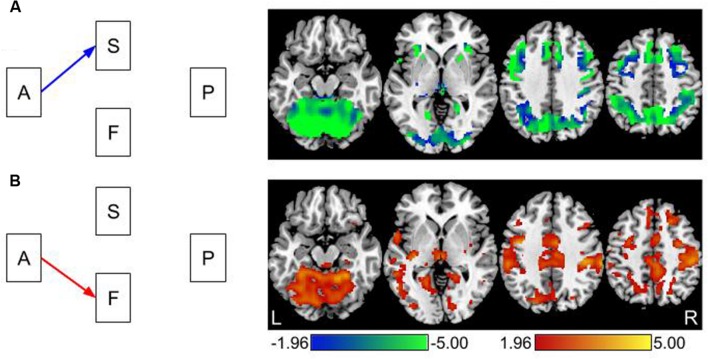
Direct effects of age on gray matter volume and brain activity.
(A) The effect of age on gray matter volume using voxel based morphometry (VBM). All effects are in the negative direction; older adults have lower gray matter volume than young adults. This is represented with a blue arrow in the path model on the left. (B) The effect of age on brain activation. All effects are in the positive direction; older adults have greater levels of task-related brain activation than young adults. This is represented with a red arrow in the path model on the left. Images are thresholded using a two-tailed test of p < 0.05, Z > 1.96.